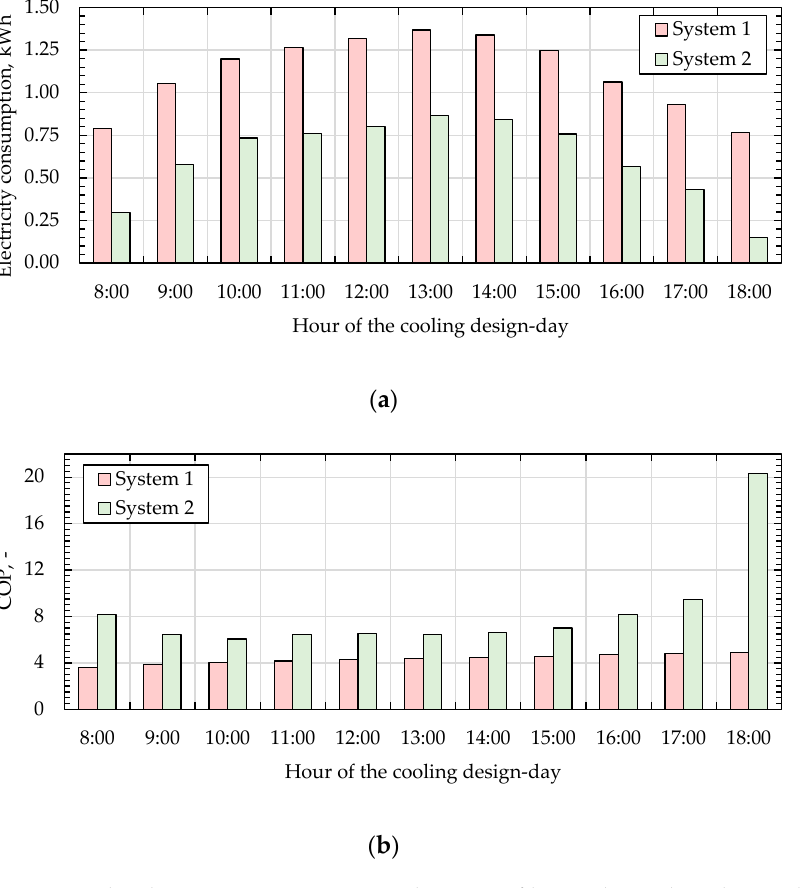
Figure 11. The electricity consumption and COP profiles on the cooling design-day: ( a ) System 1; ( b ) System